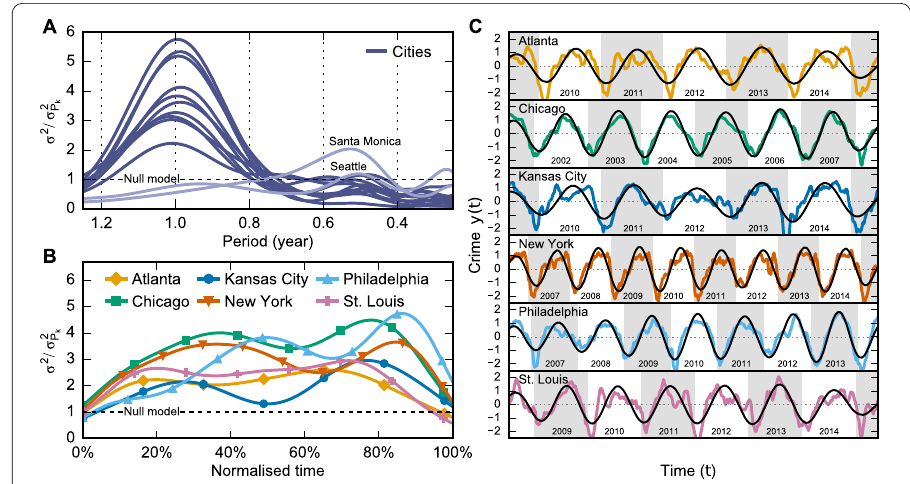
Figure 1 Most of the analysed cities show a stationary circannual crime cycle. We estimated the criminal periodicity using the global wavelet spectrum ( A ) from the wavelet transform of the city-level time series (each solid curve), then compared against the null model P k generated from autocorrelated random noise (dashed line); only Santa Monica and Seattle failed to have the significant 1-year period (lighter colour). With the scale-averaged wavelet power (shown in ( B ) for selected cities), we found that these cycles are statistically stationary throughout the time series, except for Portland. Normalised time refers to the proportional amount of time to the whole time series. The temporal regularity can be seen in the reconstructed waves of crime ( C ) using only the circannual band (black curves)